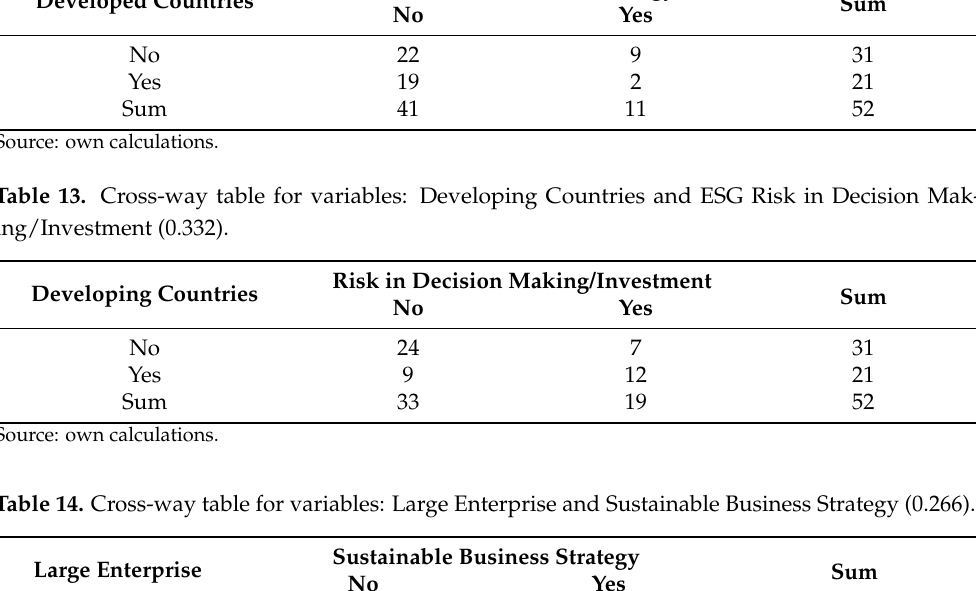
Table 12. Cross-way table for variables: Developed Countries and Sustainable Business Strategy (0.228). Developed Countries